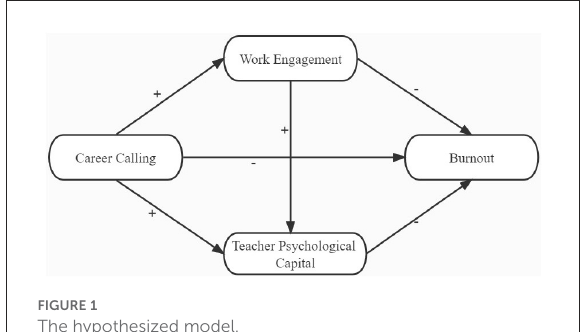
FIGURE1 The hypothesized